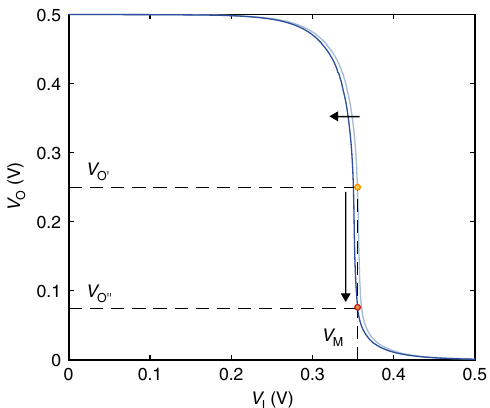
Fig. 3 Ionic-to-electronic ampli fi cation mechanism. To operate the organic electrochemical transistor complementary ampli fi er with high sensitivity, the input voltage is biased at V I = V M , while the output voltage is continuously measured. Light-blue characteristic: at V I = V M the output V = V c O O ’ and the ion concentration is 0 . A small variation of the ion concentration results in a shift of the electrical characteristic (from light- blue to dark-blue) and this, in turn, in a large variation of the output voltage from V O ’ to V O ”